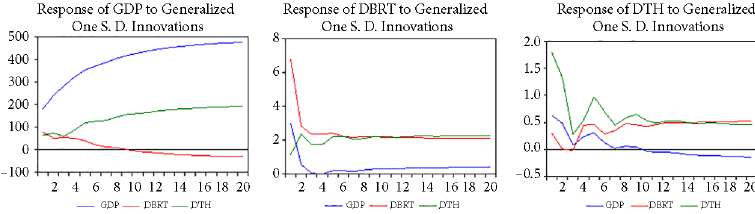
Figure 3. Response of model of Cluster B to Generalized One S.D. Innovations (source: authors ‘own